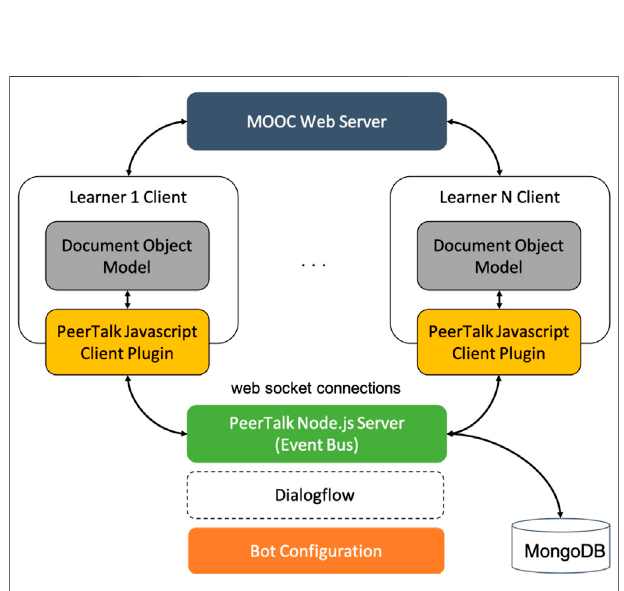
FIGURE 2 | The architecture of the PeerTalk